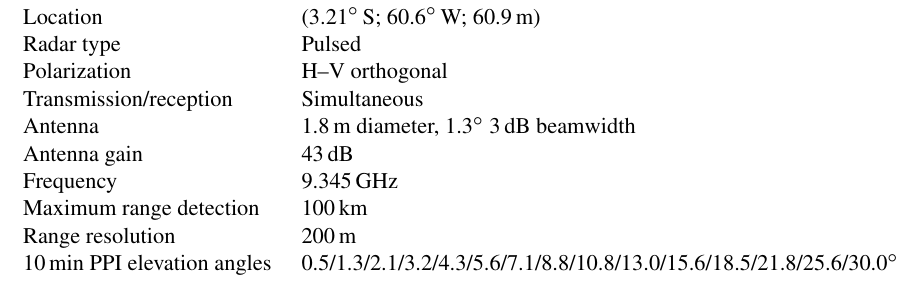
Table 1. X-band dual-polarization radar